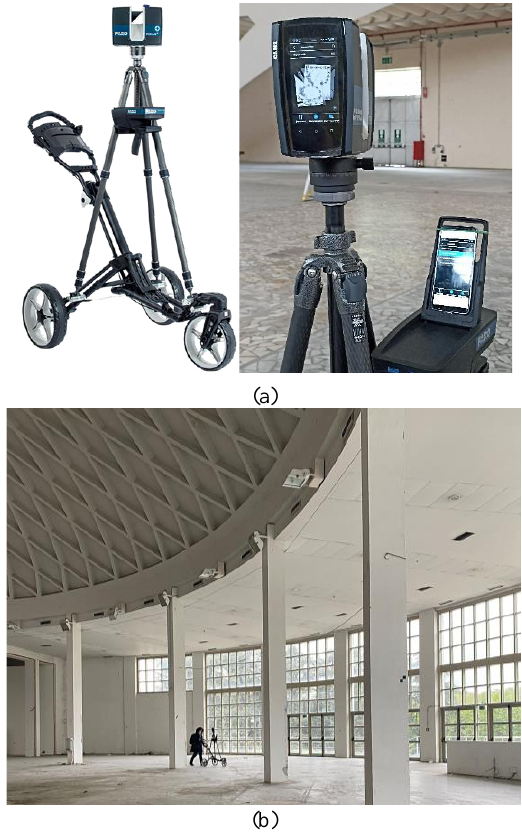
Figure 1. The components of the Swift System by FARO Technologies (a). A view of the acquisition phase in the Torino Esposizioni Hall